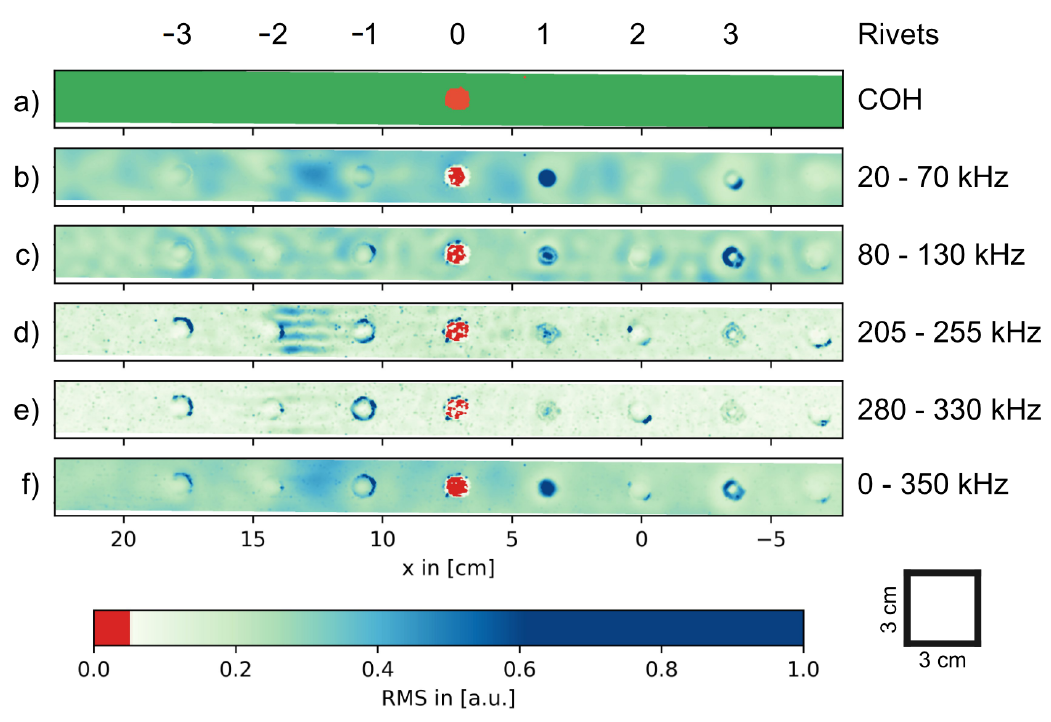
Figure 7. The coherence analysis ( a ) and band pass filtered and normalized RMS for different frequencies for area II ( b – f ) of the fuselage panel. The color bar at the bottom refers only to ( f ) as it is adapted for each filter according to the description